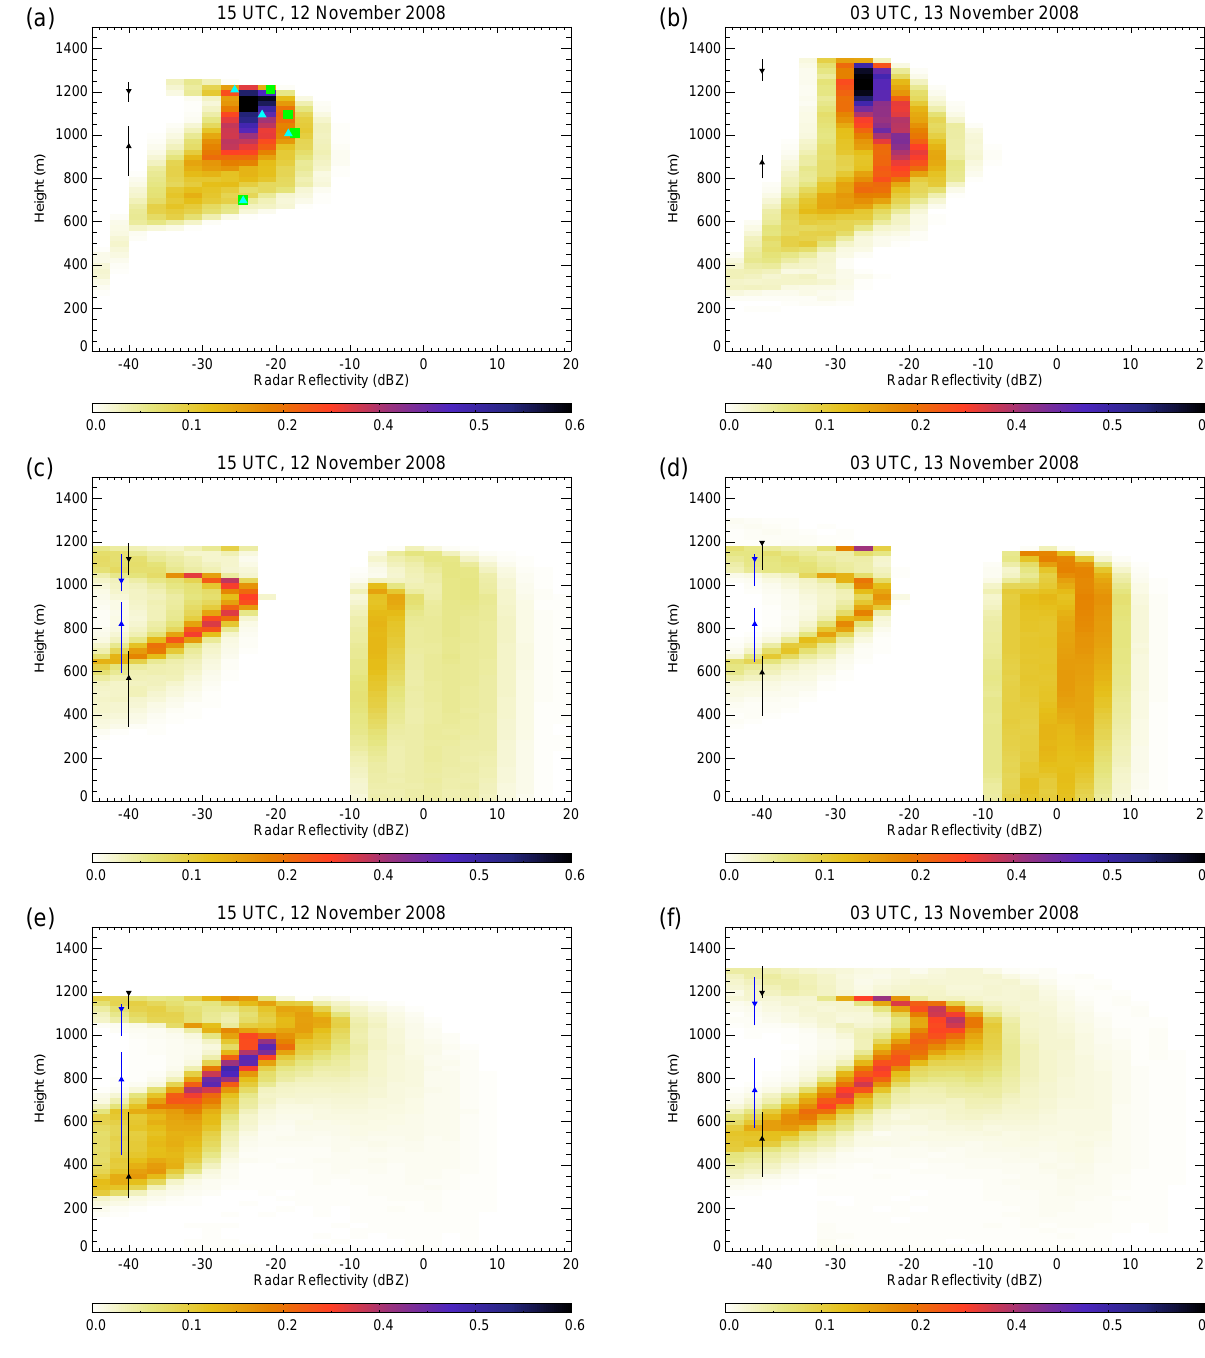
◦ box surrounding the